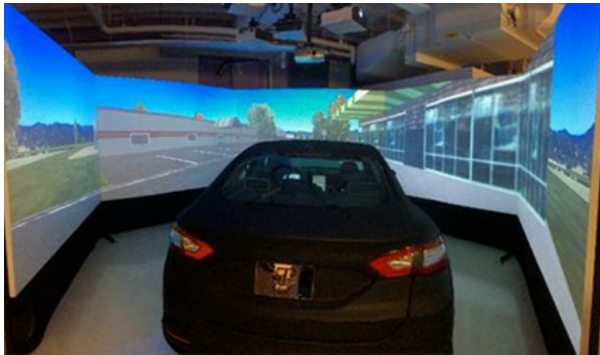
Figure 1 Fixed-base driving simulator users, and commonplace driving events and